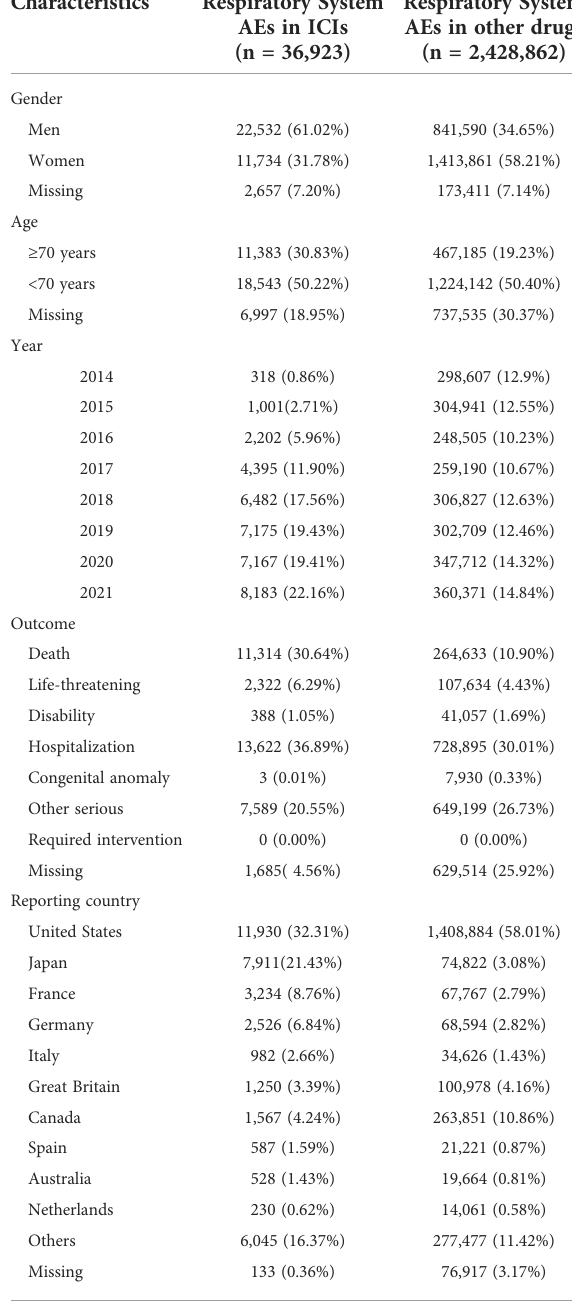
TABLE 2 Characteristics of respiratory system AEs in the ICI group and control